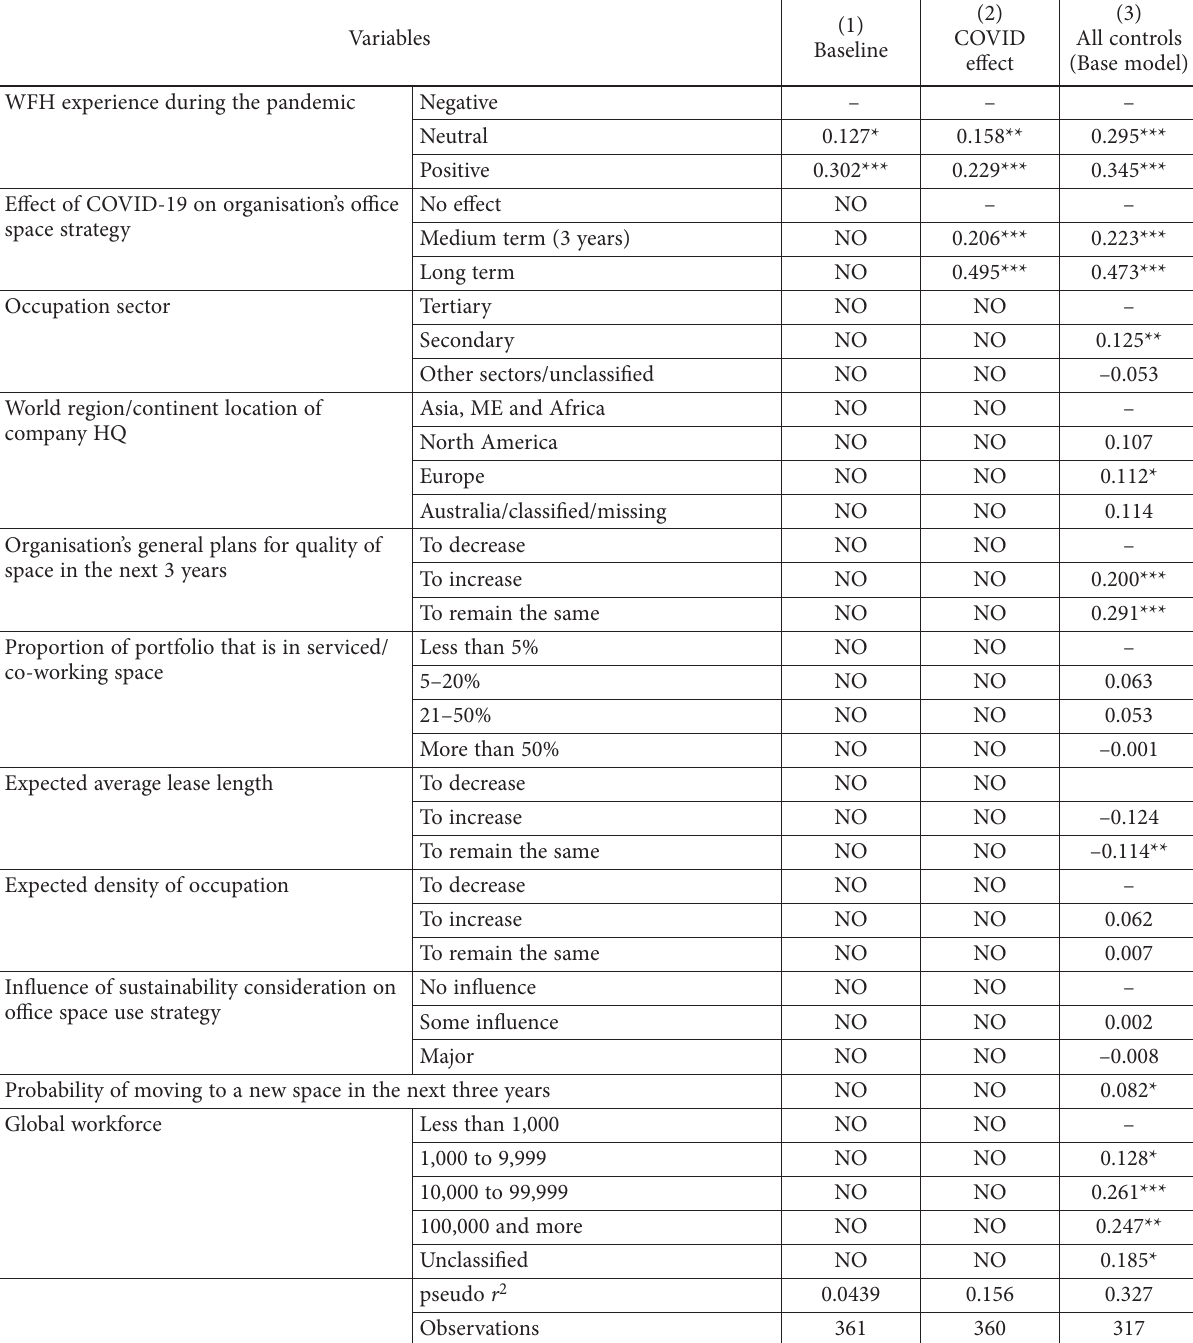
Table 1. Probit showing office space quantity (decrease) expectation within the next three